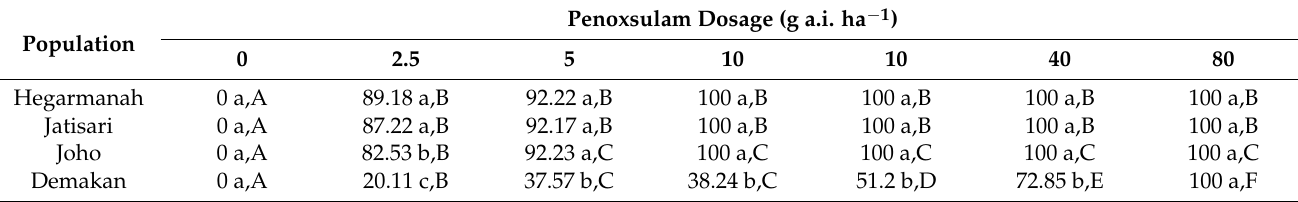
Table 1. Effect of penoxsulam on the percentage of damage to L. decurrens